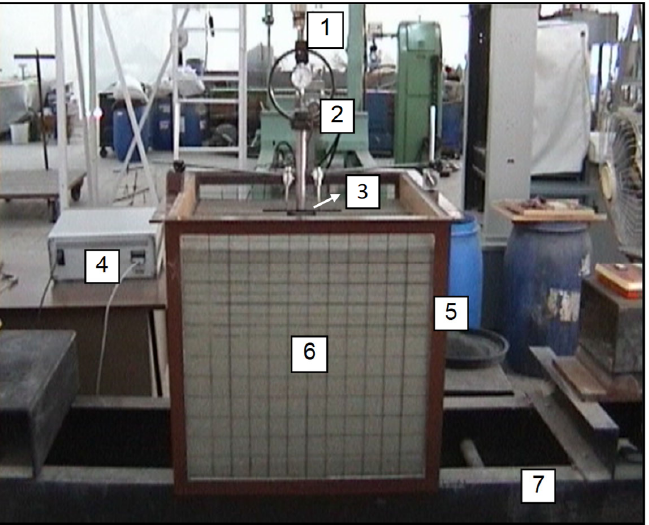
Figure 2. Test set-up: ( 1 ) mechanical jack; ( 2 ) proving ring; ( 3 ) model plate; ( 4 ) datalogger; ( 5 ) steel profile; ( 6 ) sand bed; ( 7 ) reaction beam.